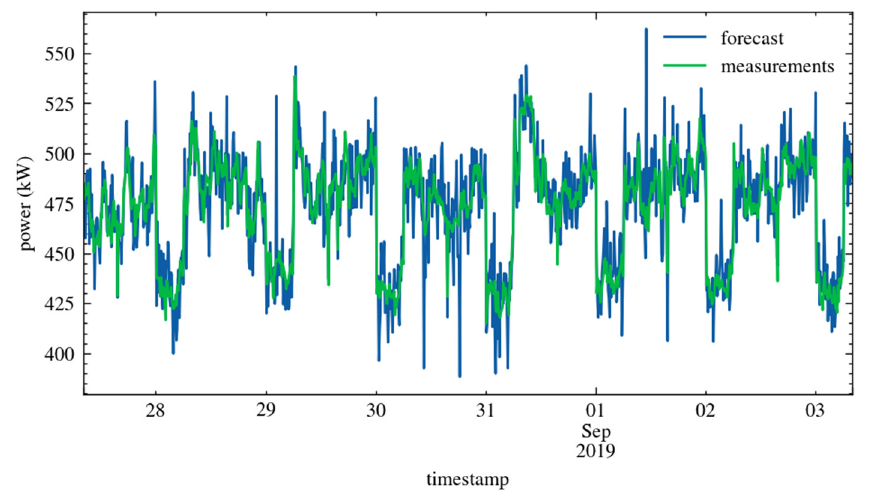
Figure 9. Measured and forecasted load demand profiles for the accommodation MG.